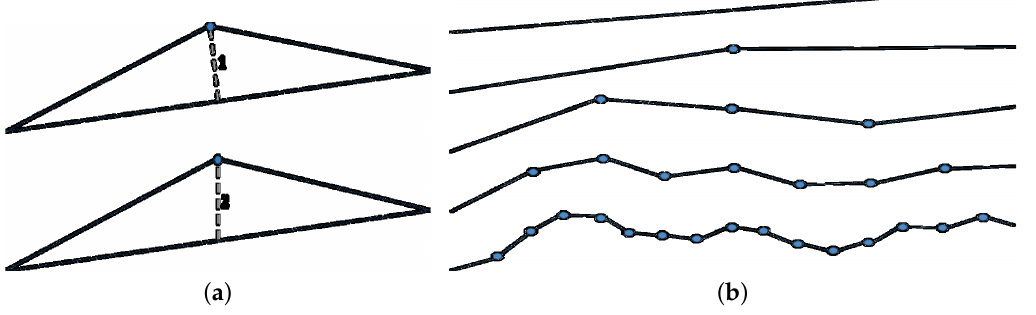
Figure 7. ( a ) Strategies to displace the midpoint and ( b ) Successive iterations of the algorithm (from left to right). (Image source: https://bitesofcode.wordpress.com/2016/12/23/landscape-generation- using-midpoint-displacement/, accessed on 22 June